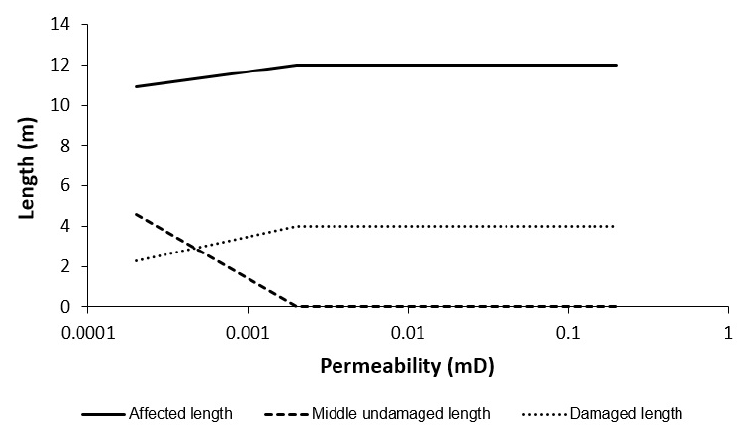
Figure 13. Comparison of models for different permeabilities.